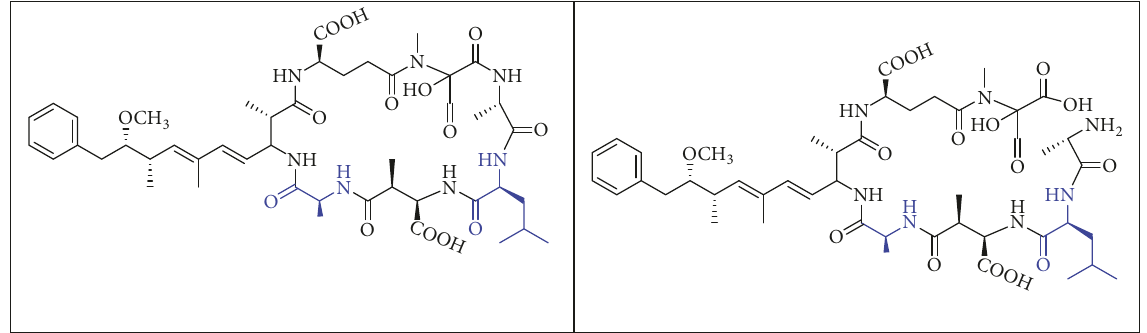
Figure 7: Two OP isomers, OP11 and OP13, with intact Adda that are likely interferents. Note that OP13 is an open ring.